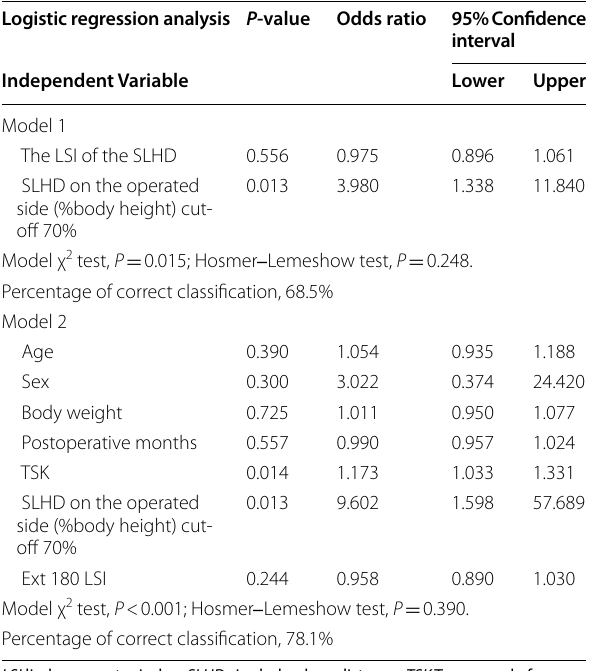
LSI limb symmetry index, SLHD single-leg hop distance, TSK Tampa scale for kinesiophobia Ext 180 represents the isokinetic knee extension torque at 180°/s